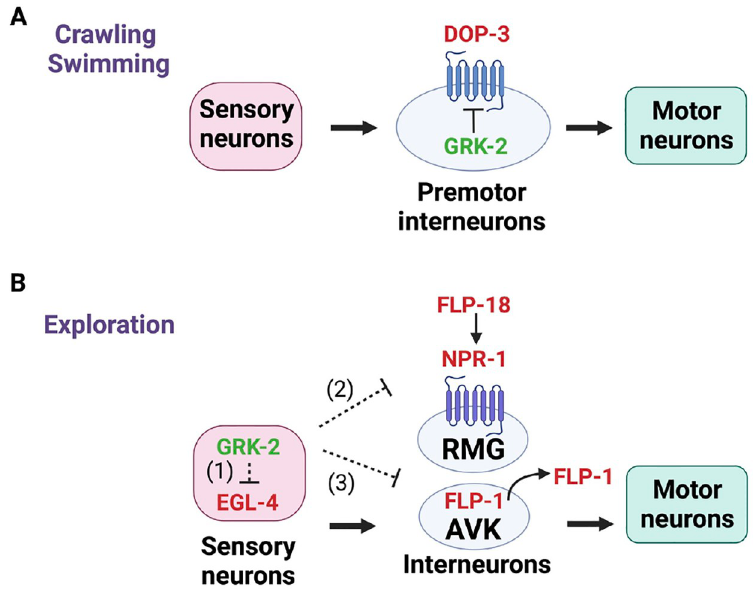
Fig 9. Model for GRK-2 modulation of locomotion behaviors in C . elegans . GRK-2 positively controls (A) crawling and swimming by acting in premotor interneurons in a manner that depends on the D2-like dopamine receptor DOP- 3 [27,28] and (B) exploration by acting in ciliated neurons in an opposite way from EGL-4. We propose a model in which GRK-2 acts in multiple ciliated sensory neurons to positively control sensory perception and (1) inhibit the activity of the EGL-4 kinase in the same ciliated neurons, (2) negatively regulate the neuropeptide receptor NPR-1 in RMG interneurons in a cell-nonautonomous way (e.g. by regulating the level of secretion of an NPR-1 ligand), and (3) negatively control the levels of FLP-1 secretion from AVK interneurons. AVKs play critical roles in regulating locomotion by modulating motor neuron activity [36]. Since the ciliated neurons and AVK interneurons do not have direct connections, we propose that GRK-2 controls FLP-1 secretion from AVK interneurons in a cell- nonautonomous way through a neuromodulatory pathway. Proteins that positively regulate crawling, swimming, or exploration are shown in green and proteins that negatively regulate crawling, swimming, or exploration are shown in red. Dashed lines show indirect interactions. Created with BioRender.com.